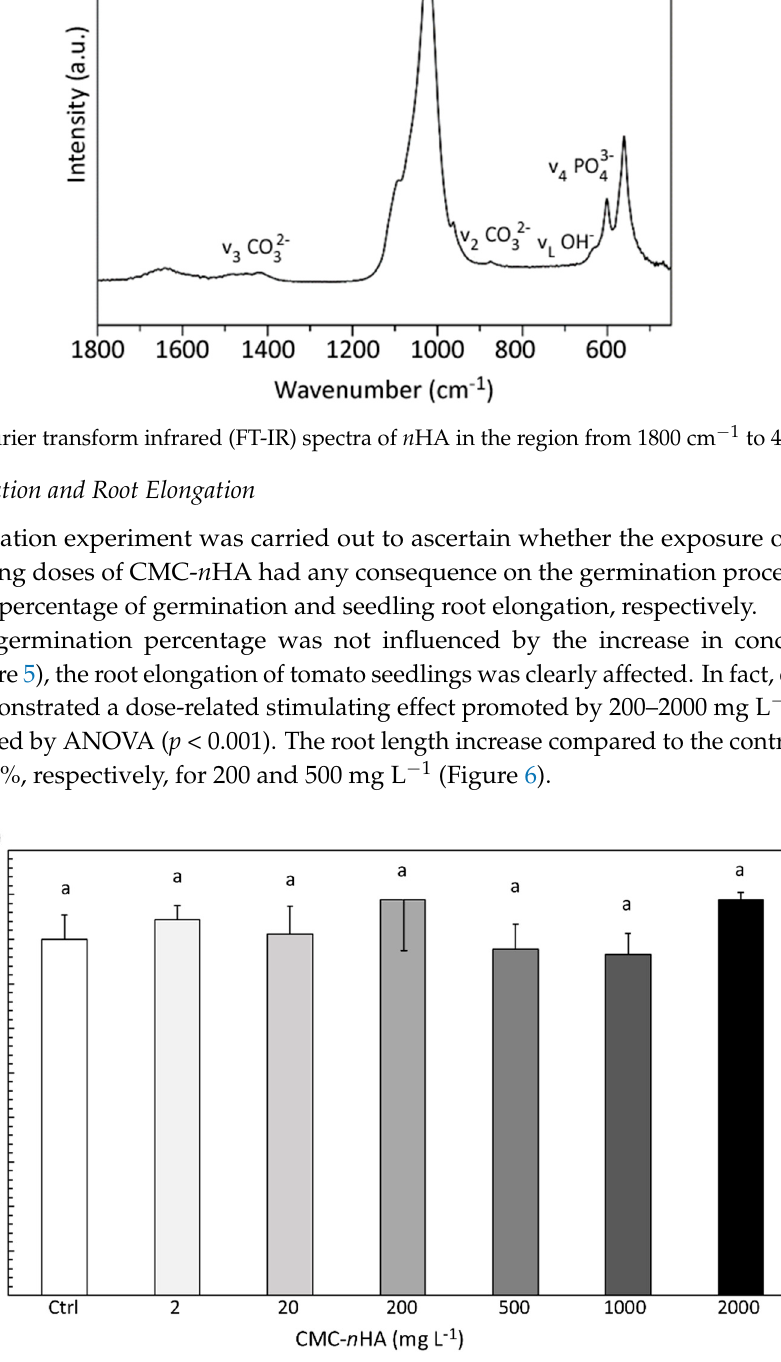
Figure 5. Effect of CMC- n HA on the percentage of germination of S. lycopersicum . Bars represent the mean standard deviation. Different letters indicate statistically significant differences between treatments (LSD test, p ≤ 0.05).